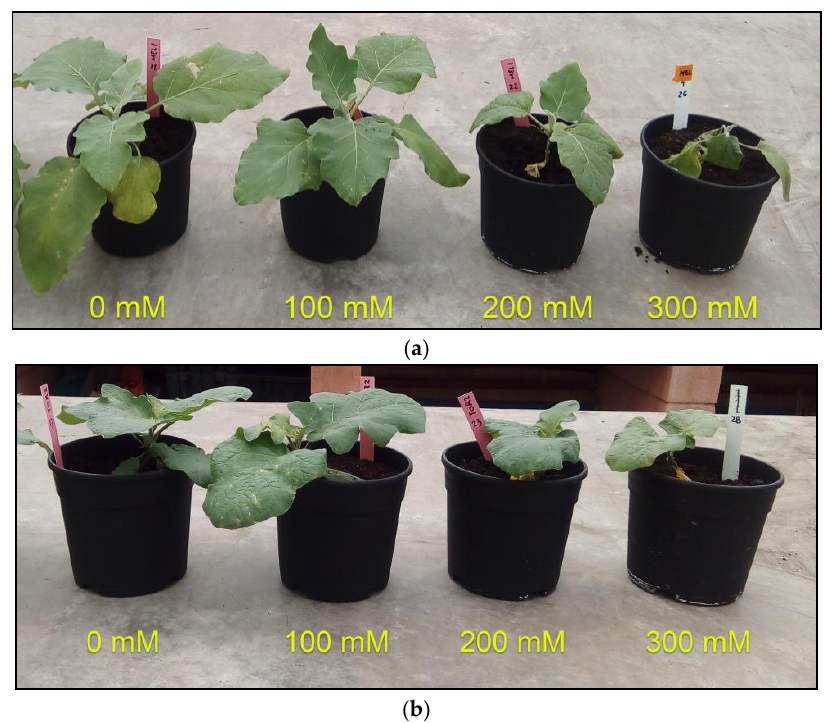
Figure 1. Young plants of Solanum melongena ( a , top) and S. torvum ( b , bottom), showing the effects of 25 days of irrigation with NaCl solutions of the concentrations indicated below each pot.